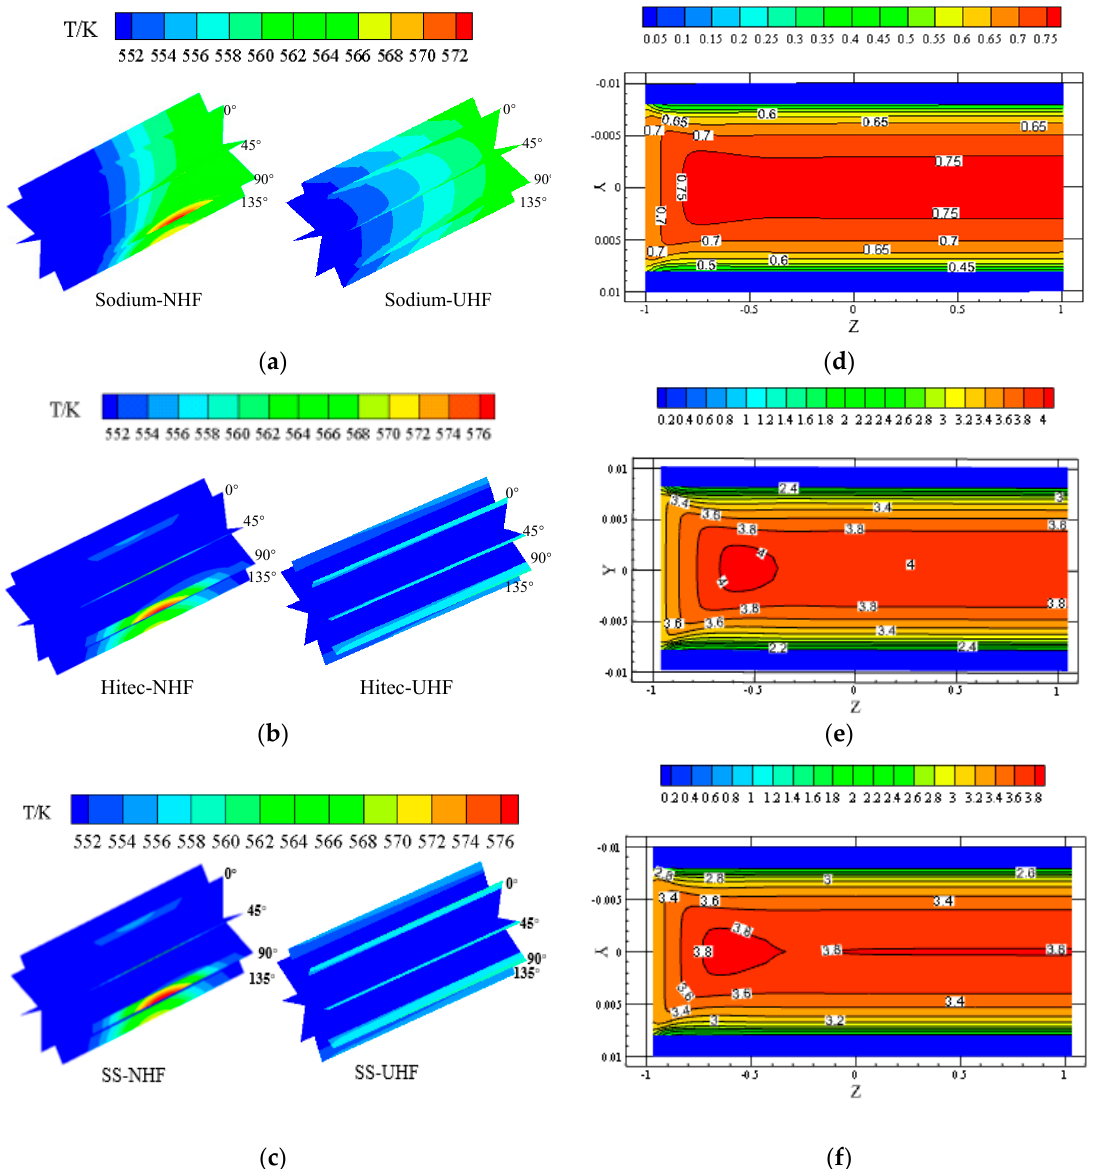
Figure 9. (a–c) Temperature distribution of three kinds of media under two models and (d–e) Figure 9. ( a – c ) Temperature distribution of three kinds of media under two models and ( d , e ) velocity velocity distribution under NHF model. distribution under NHF